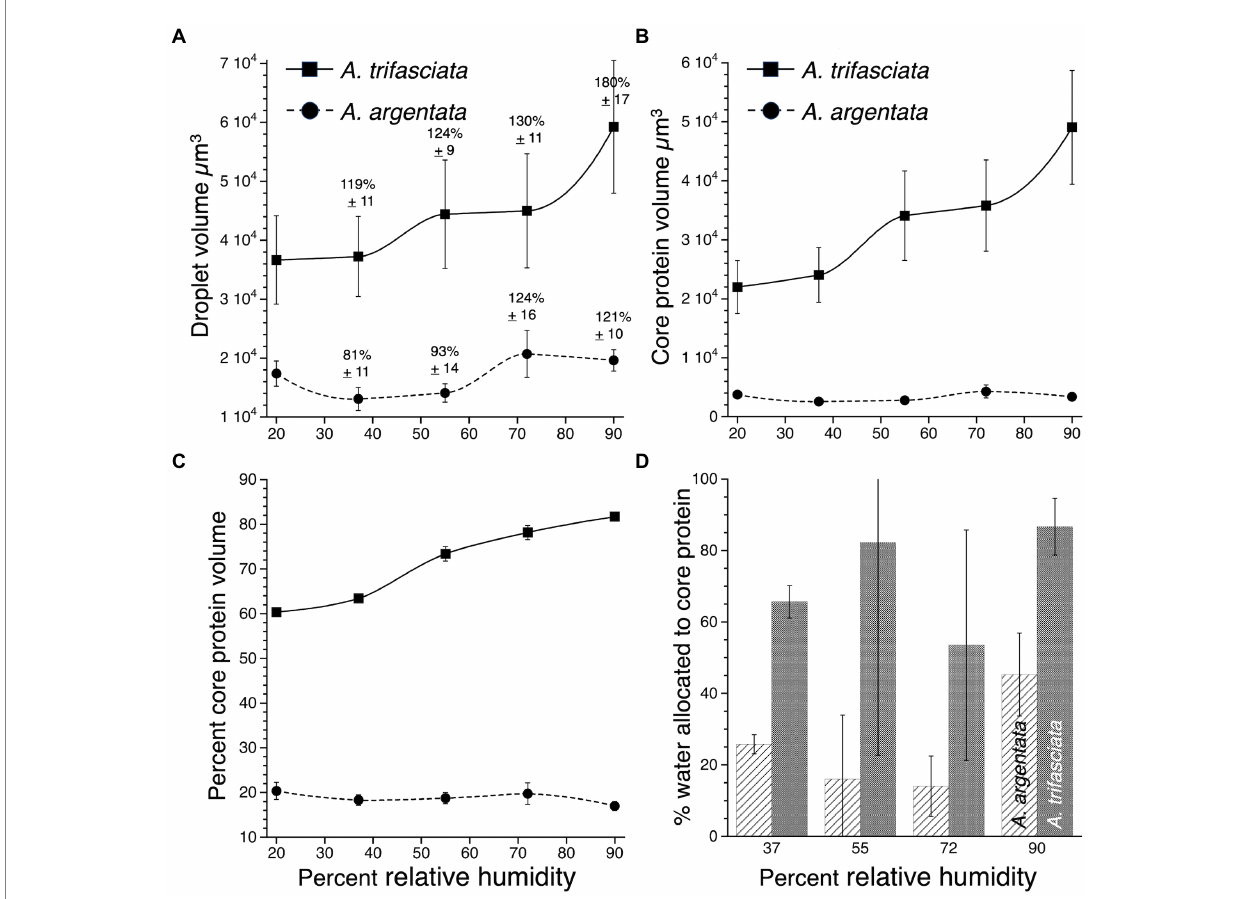
FIGURE 2 Comparison of A. argentata and A. trifasciata droplet features at five humidities: (A) . Droplet volume showing percent changes in volume compared with volume at 20% RH, (B) . Protein core volume, (C) . Percent of droplet volume occupied by the protein core, and (D) . Percent of absorbed atmospheric water allocated to a droplet’s protein core. Values are mean ± standard